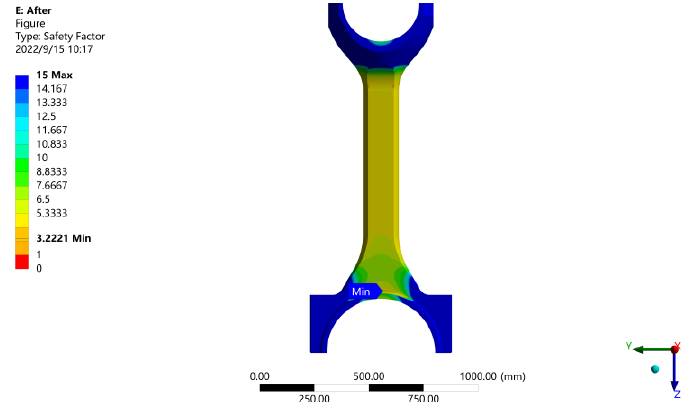
Figure 19. Stress diagram of optimized connecting rod body.